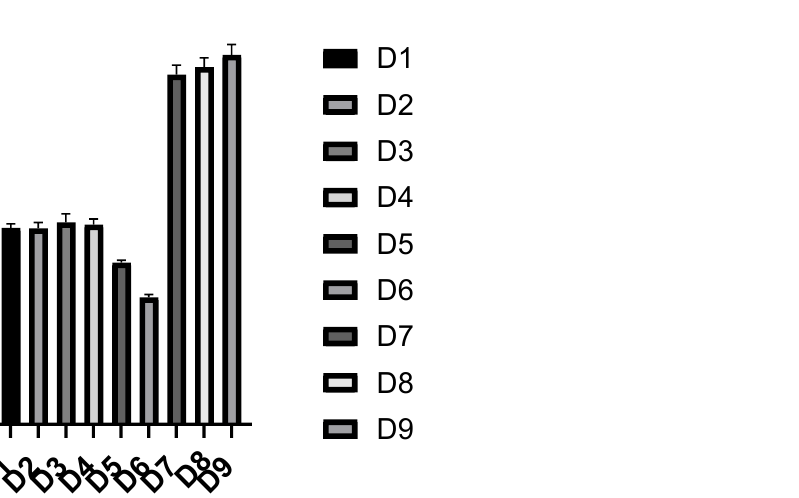
Figure 1. The swelling profiles of the polymeric formulations (mean ± SD, n = 3) at pH 1.2 and pH 7.4.